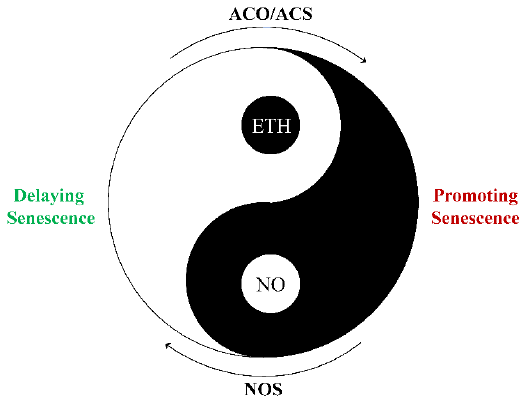
Figure 2. Model for the crosstalk between ETH and NO during the postharvest senescence process. The ‘Yin–Yang’ symbol represents the balance of ETH and NO generation through ACS/ACO and NOS pathways, respectively. ACO, 1-aminocyclopropane-1-carboxylic acid oxidase; ACS, 1-aminocyclopropane-1-carboxylic acid synthase; ETH, ethylene; NO, nitric oxide; NOS, NO synthase.